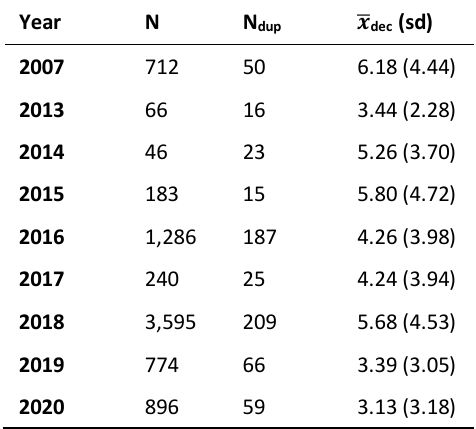
Table 3. Duplicate sightings from visual aerial surveys of cetaceans in Atlantic Canada in 2007 and 2013-2020. The data were collected by 2 observers in bubble windows on the right side of a Twin Otter aircraft, with a data recorder sitting between the bubbles. N is total number of cetacean sightings, N dup is the total number of duplicates, and average difference in declination angles of duplicate sightings with standard deviation in parentheses. The 2020 survey is